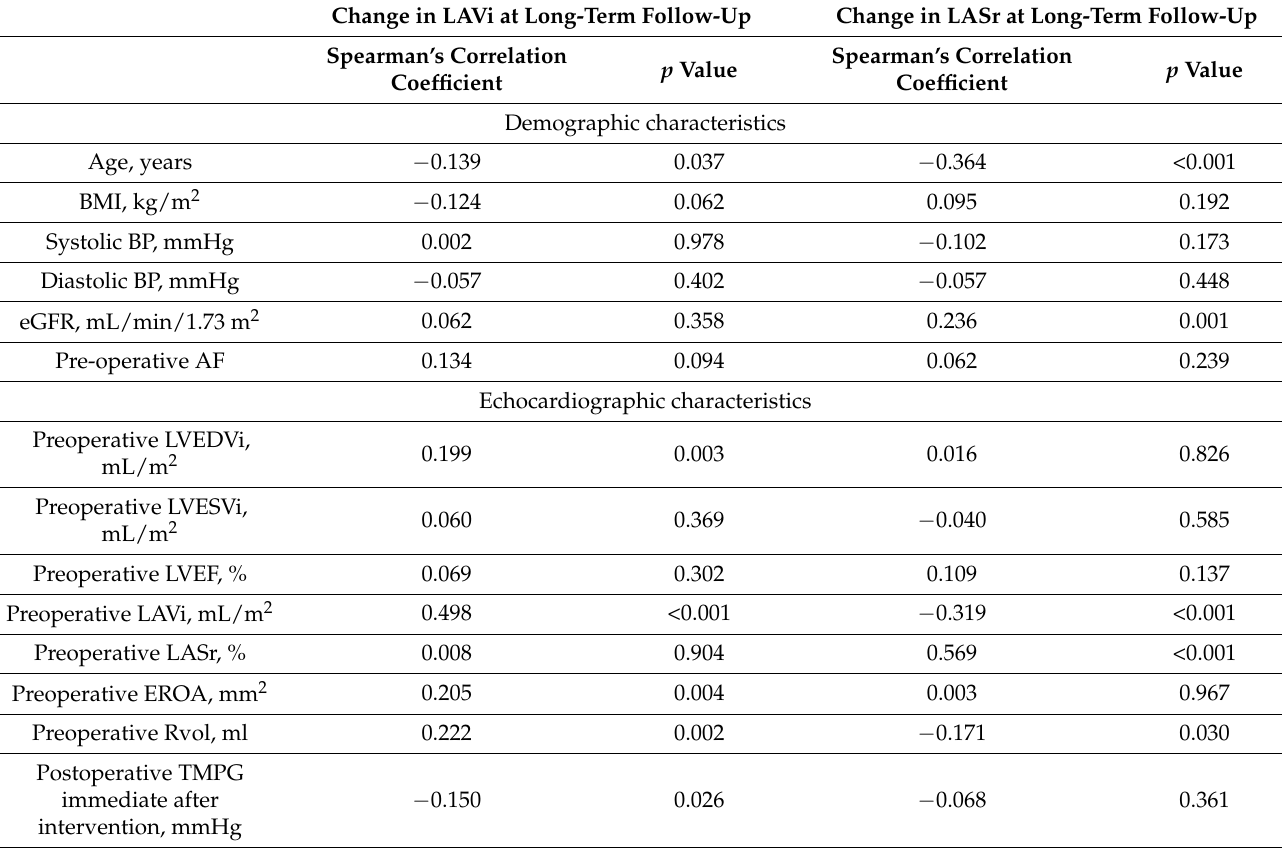
Table 3. Univariate correlates of changes in LA volume and function at long-term follow-up after mitral valve